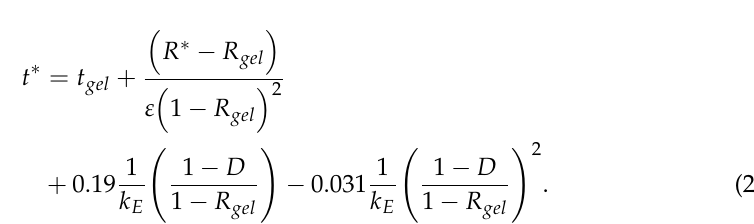
From the measured parameters, k E e k E t gel ≈ e , giving